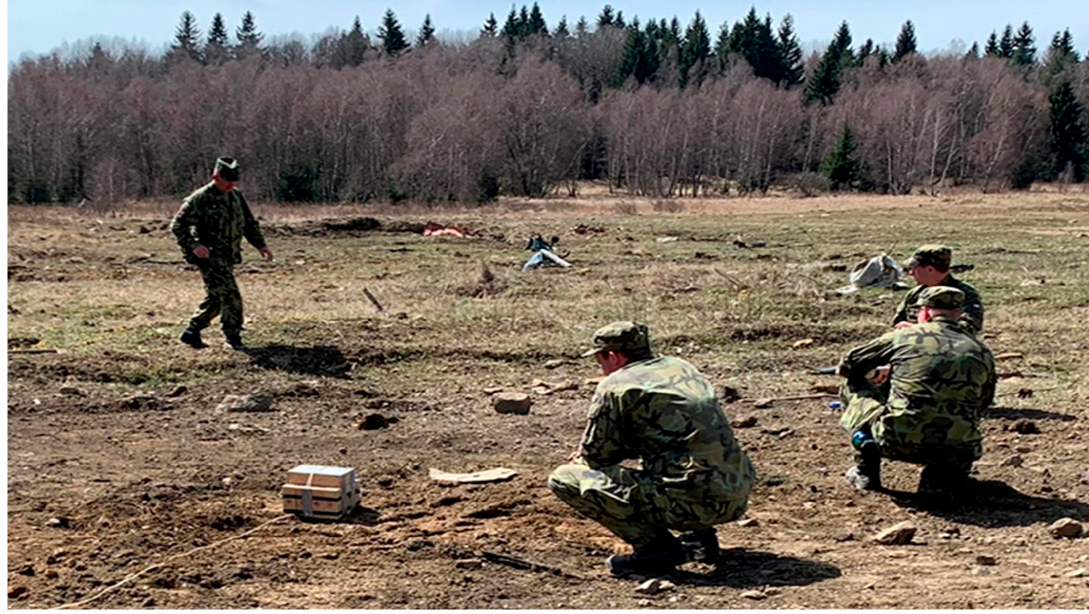
Figure 12. Installation of a TNT charge and an optical fiber sensor for measuring 5 kg of TNT (Boletice Military Training Area, Praža č ka Artillery Pit).